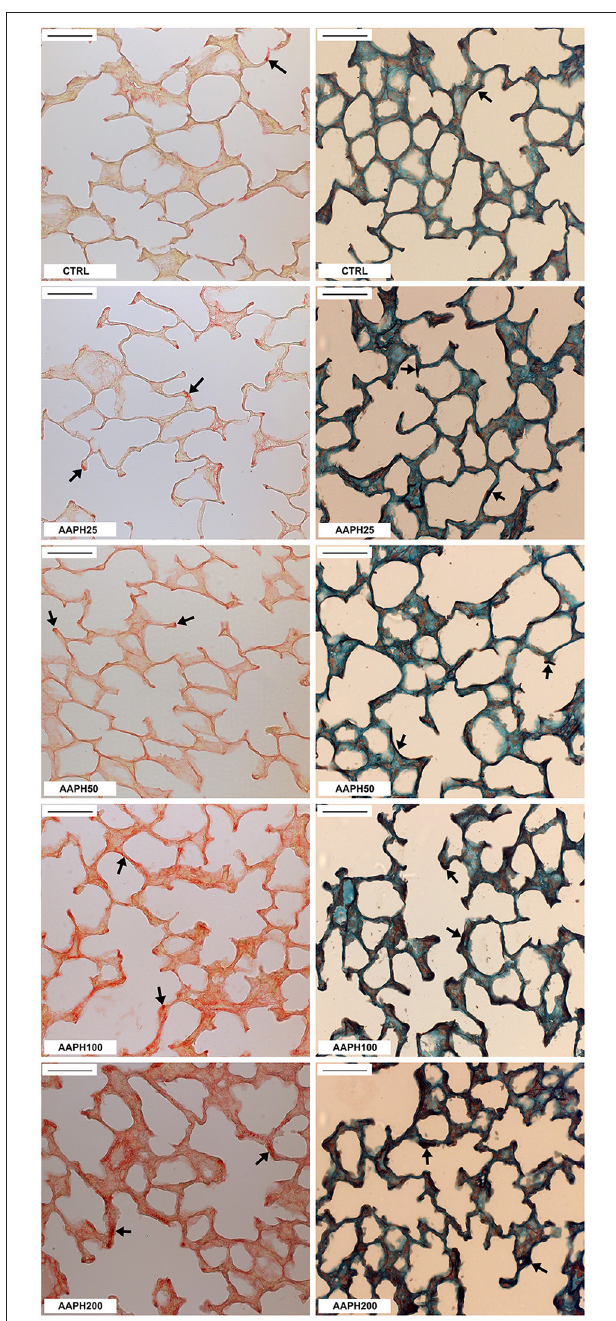
FIGURE 3 | Collagen and elastic fibers in the lung parenchyma. Photomicrographs of lung parenchyma showing collagen (left column) and elastic fibers (right column). Measurements were done 72 h after the exposure of animals to saline solution (CTRL) or different amounts of 2,2 ′ -azobis (2-amidinopropane) dihydrochloride (AAPH25, 50, 100, and 200 mg/kg in saline solution). Arrows indicate collagen and elastic fibers. Bars